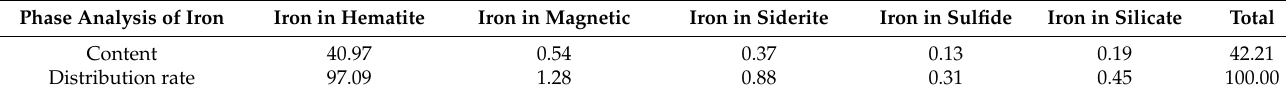
Figure 1. Iron phase analysis process.